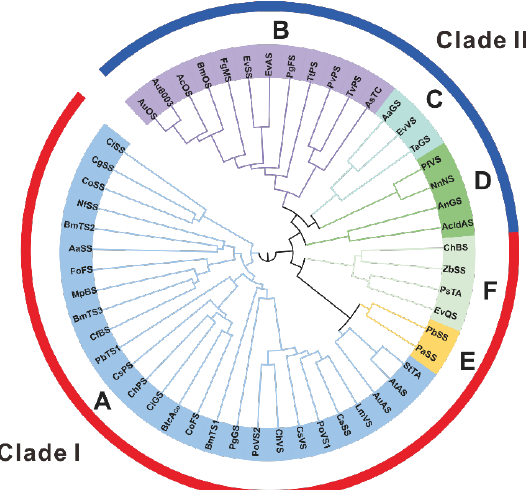
Figure 4. Phylogenetic tree analysis of fungal PTTSs with the maximum-likelihood method. The phylogenetic tree was constructed by IQ-TREE v 1.6.9 based on the full-length sequences of 52 PTTSs and presented in Figtree v1.4.4. A – F denote six subfamilies of PTTSs, where A, E, and F are in clade I, and B, C, and D are in clade II.